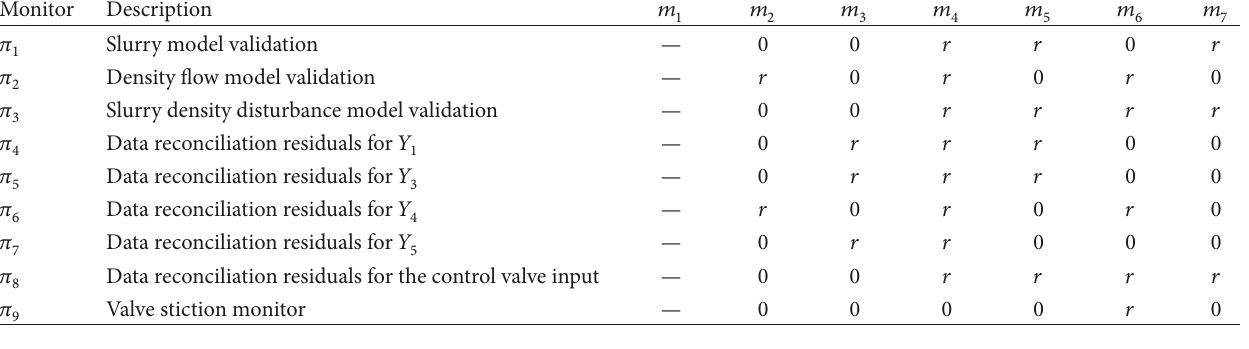
Table 3: Monitors and a priori response information.